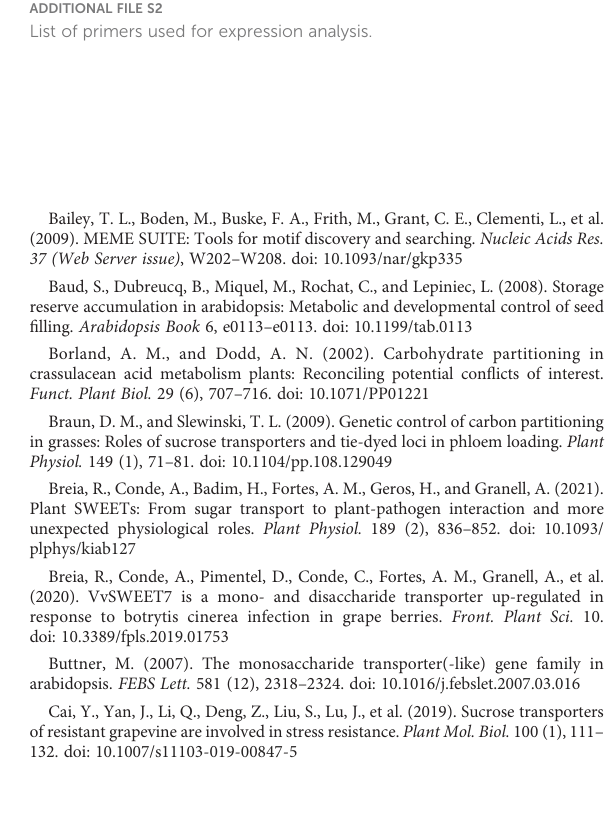
ADDITIONAL FIGURE 1 Phylogenetic analysis of the early response dehydration 6 / sugar facilitator protein family (ERD-6). ADDITIONAL FILE S1 List of the sequences used in the